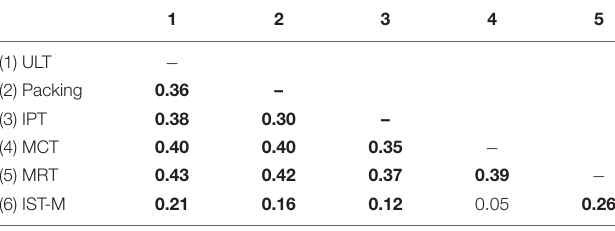
TABLE 2 | Correlations between observed test scores.